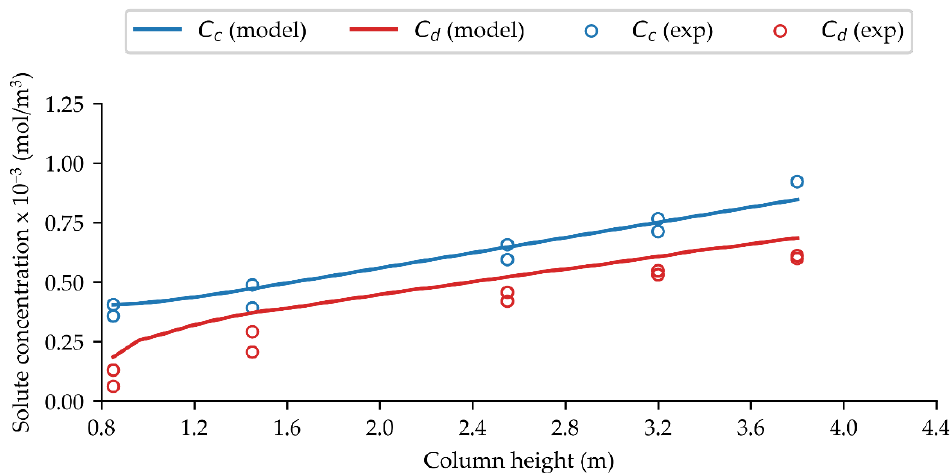
Figure 9. Experimental and modelled profiles of PSEC solute concentration in the organic and aqueous phase.